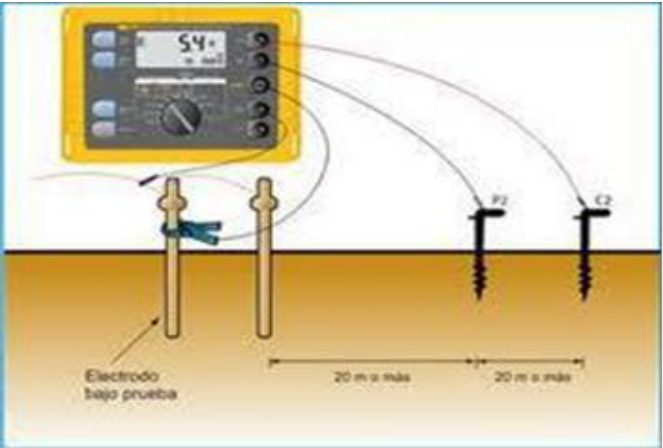
Figura 13: Método de Frank Wener con telulómetro para medir resistencia del terreno.